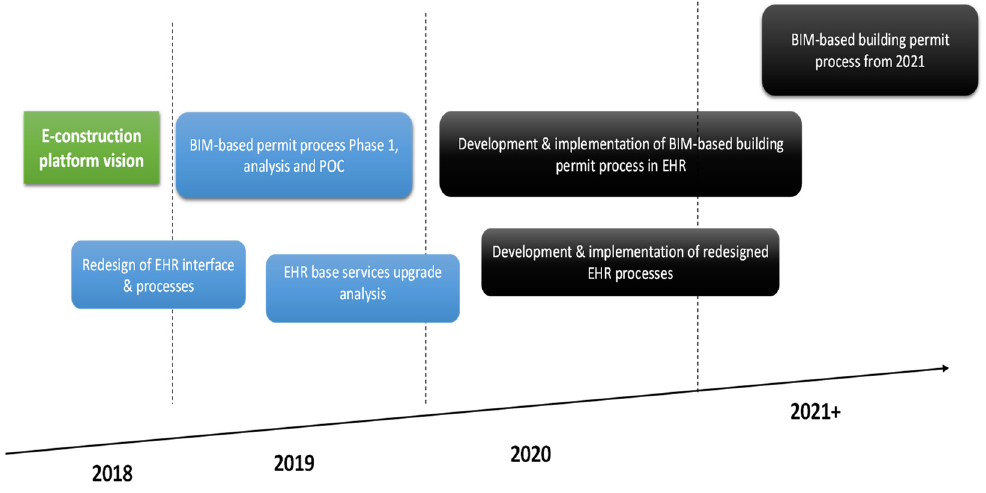
Figure 3. Roadmap for the BIM-based building permit process (source: Estonian Ministry of Economic Affairs and Communication).